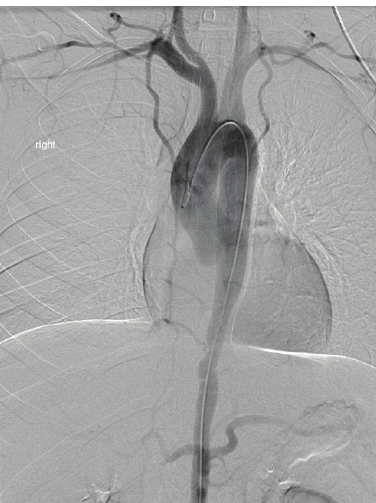
Figure 2: Follow-up thoracic and abdominal angiogram 14 months later: severe tapering of the subclavian arteries bilaterally, narrowing, and irregularity of distal aorta. The ascending aorta measured 2.5 cm whereas the distal thoracic aorta measured only 1.2cm in diameter and tapered to 7.5 mm transversely at the narrowest point just beyond the aortic